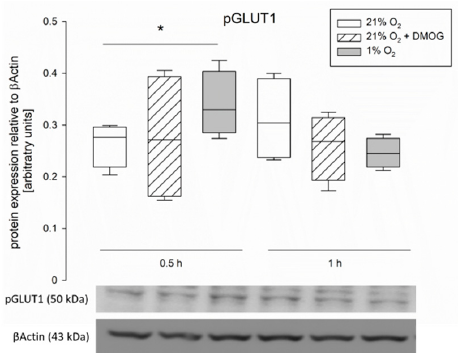
Figure 6. Protein expression of pGLUT1 in CaCo-2 cells detected by Western blot. Cells were incubated at 21% O 2 (white bars) or at 21% O 2 with 3 mM DMOG (hatched bars) or subjected to hypoxia (grey bars). There is a significant difference after 0.5 h of incubation at 1% O 2 compared to 21% O 2 . Representative blots are shown below. Boxes show the median, 10th, 25th, 75th, and 90th percentile plus error bars. Outliers are represented by dots. Paired t-test, p < 0.05, N = 4.